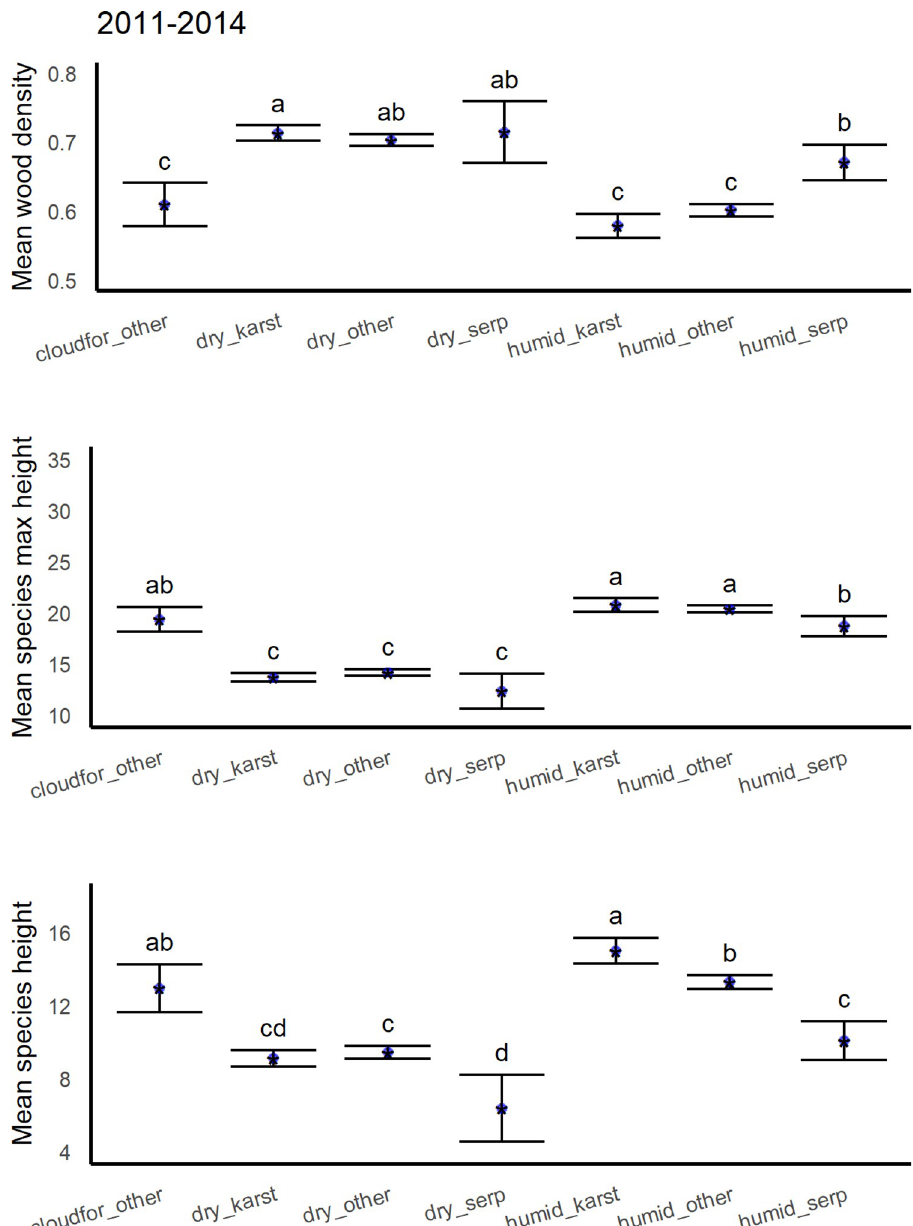
Fig 11. Mean wood density, maximum species height and typical species height of species in different geoclimatic vegetation zones (see Table 3) from the years 2011–2014 (cloudfor_other is cloud forest, dry_karst is dry forest on limestone substrate, dry_other is dry forest on other substrates, dry_serp is dry forest on serpentine substrate, humid_karst is moist to wet forest on limestone substrate, humid_other is humid forest on other substrates, humid_serp is moist to wet forest on serpentine